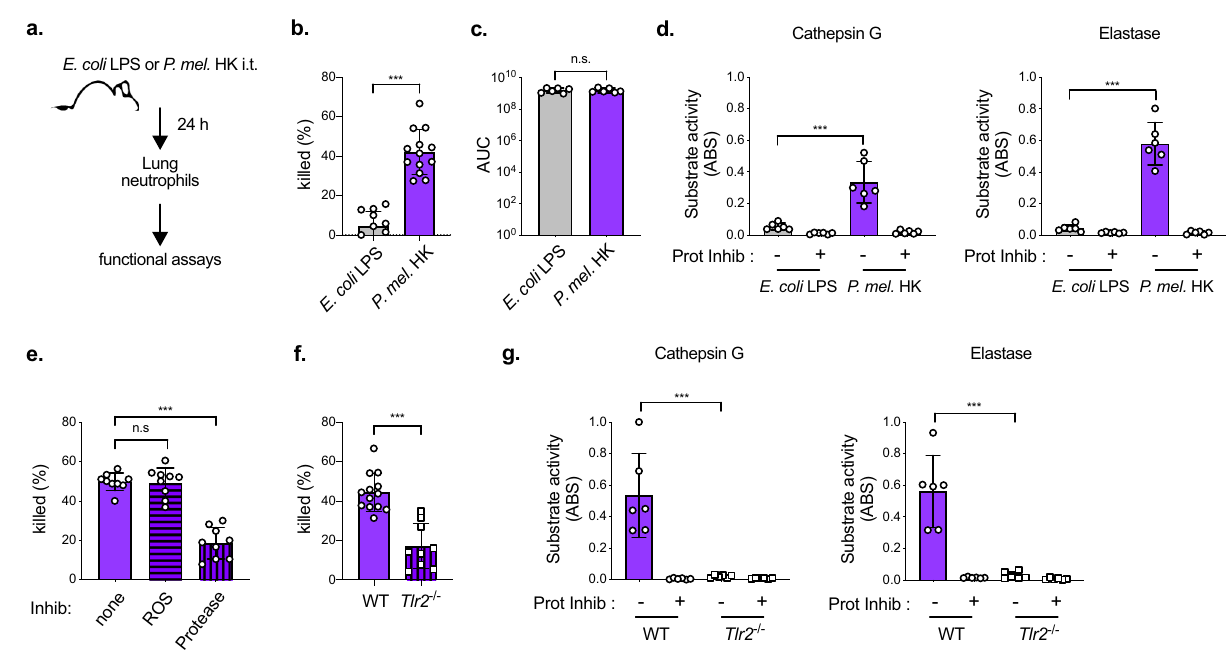
Fig. 7 P. melaninogenica ( P. mel .) enhances serine protease-mediated killing of S. pneumoniae by lung neutrophils in a TLR2-dependent manner. a Schematic of lung neutrophil puri fi cation. b Percent of type 2 S. pneumoniae killed by lung neutrophils puri fi ed from mice exposed to either E. coli lipopolysaccharide (LPS) or P. mel . strain 25845 heat-killed (HK) i.t. for 24 h following 1 h incubation with S. pneumoniae opsonized with 3% fresh mouse serum ( n = cells isolated from 11 mice/group). c Total reactive oxygen species (ROS) produced in 1 h by lung neutrophils puri fi ed from mice exposed to either E. coli LPS or P. mel . HK i.t. for 24 h detected by luminol, with area under curve (AUC) shown ( n = cells isolated from 6 mice/group). d Serine protease activity for cathepsin G and elastase + / – protease inhibitor cocktail (Prot Inhib) detected by substrate cleavage for lung neutrophils puri fi ed from WT mice exposed to either E. coli LPS or P. mel . HK ( n = cells isolated from 6 mice/group). e Percent of S. pneumoniae killed by lung neutrophils puri fi ed from WT mice exposed to P. mel . HK i.t. for 24 h following 1 h incubation with opsonized S. pneumoniae in the presence of the ROS inhibitor DPI (ROS), protease inhibitors (Protease), or no inhibitors (none), ( n = cells isolated from 9 mice/group). f , g Percent of S. pneumoniae killed by lung neutrophils puri fi ed from WT or Tlr2 -/- mice exposed to P. mel . HK i.t. for 24 h ( n = cells isolated from 13 WT mice, 9 Tlr2 -/- mice) ( f ) or serine protease activity + /